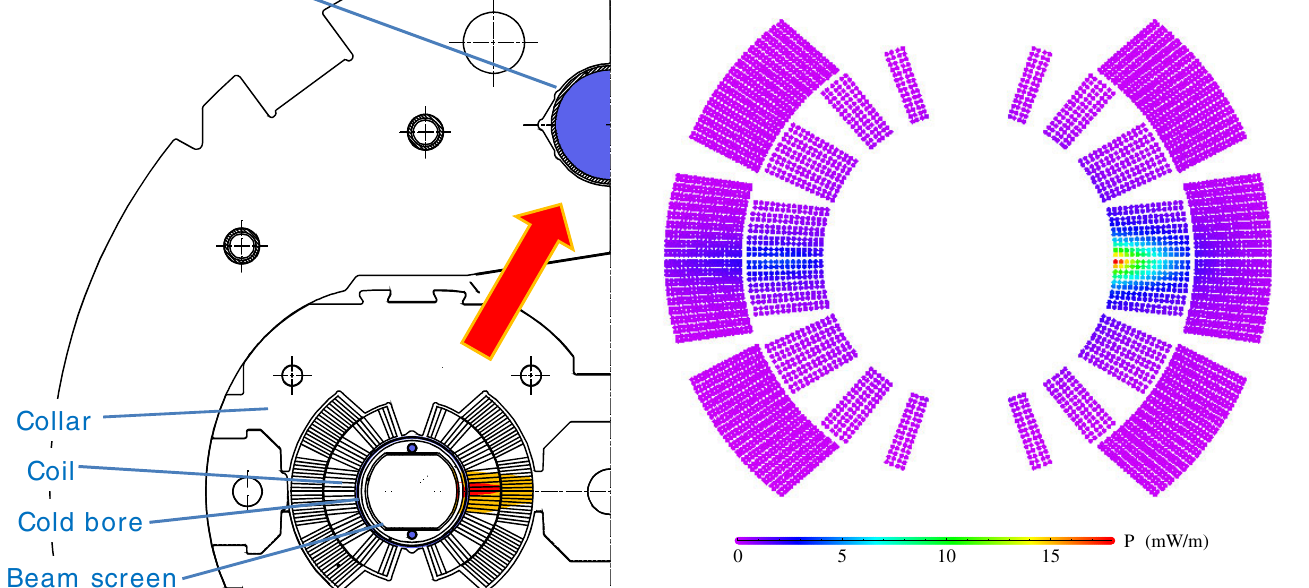
FIG. 10. (Color) Cross section of a part of an MB magnet where the red arrow schematically indicates the heat flow from the coil to the heat exchanger.